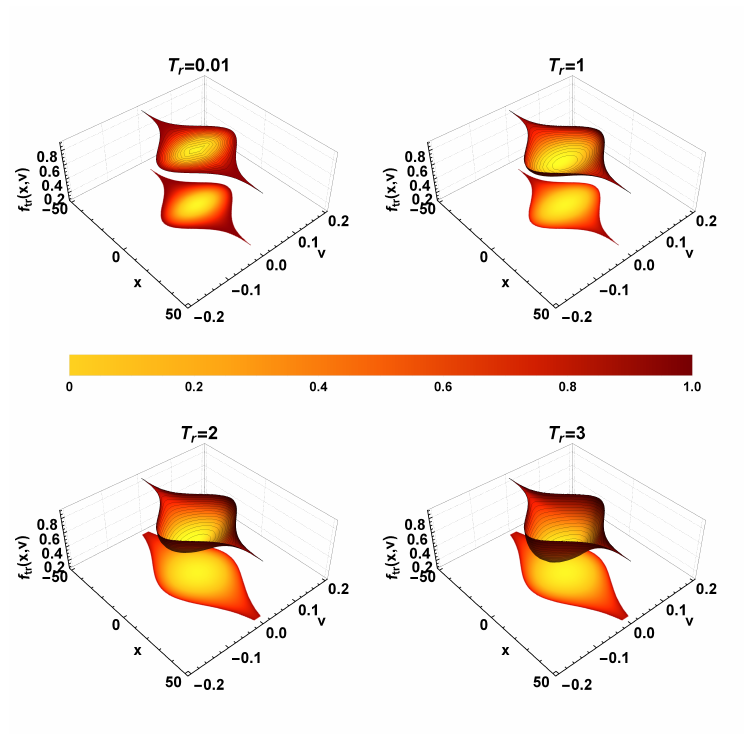
Figure 12. The trapped ion distribution function f tr ( x , v ) versus x and v , as well as 2D projection, for different values of T r , keeping δ = 10 and ψ = 0.01 constants. The values for width and amplitude are from Region 1.